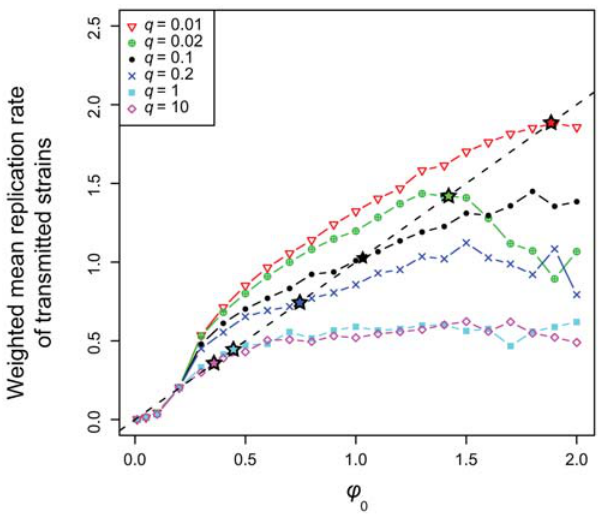
Figure 4. Weighted average replication rate of transmitted strains for different values of cross-reactive immunity ( q ). This figure is obtained by combining Figures 2A and 2C (see the main text). The average replication rates are weighted with the infection fitness values (see Figure 2A). Long-term optimal replication rates are indicated with stars, which are located at the intersection between the curves and the y ~ x line. Intuitively, if the transmitted replication rate is above the y ~ x line, the virus evolves towards higher replication rates, whereas if the transmitted replication rate is below the line, the virus evolves towards lower replication rates. Only if the transmitted replication rate is on the line do we have an evolutionarily singular strategy. Increasing cross-reactive immunity decreases the long-term optimal replication rate.